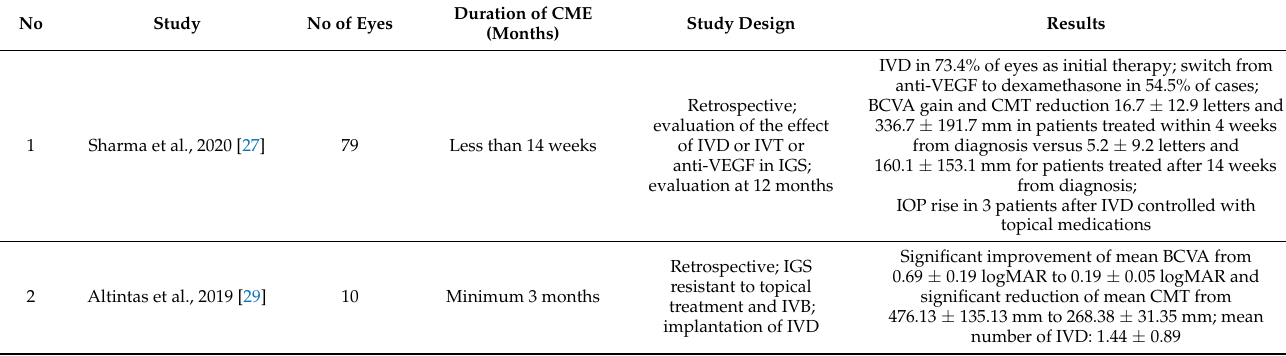
Table 5. Results of the studies analyzing the efficacy of intravitreal corticosteroids in the treatment of IGS that involved at least 10 cases and were published since